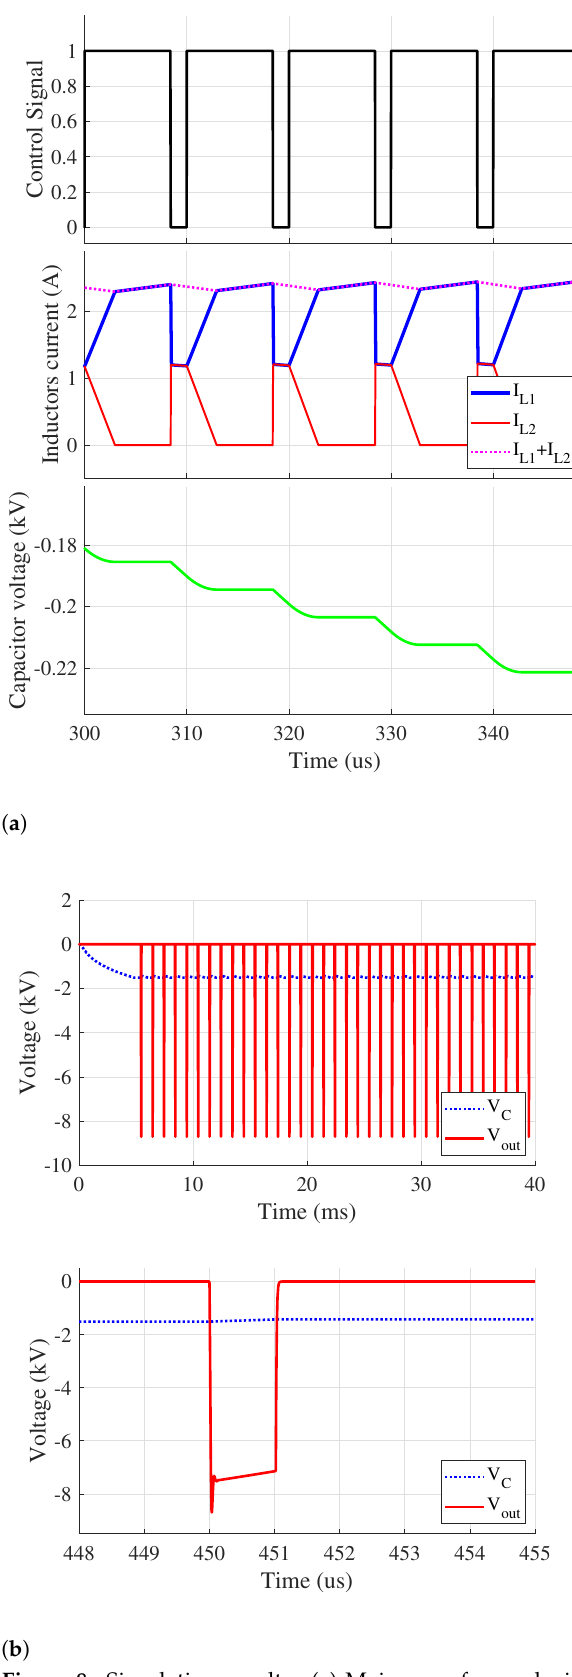
Figure 8. Simulation results. ( a ) Main waveforms during the charging phase, ( b ) output pulse